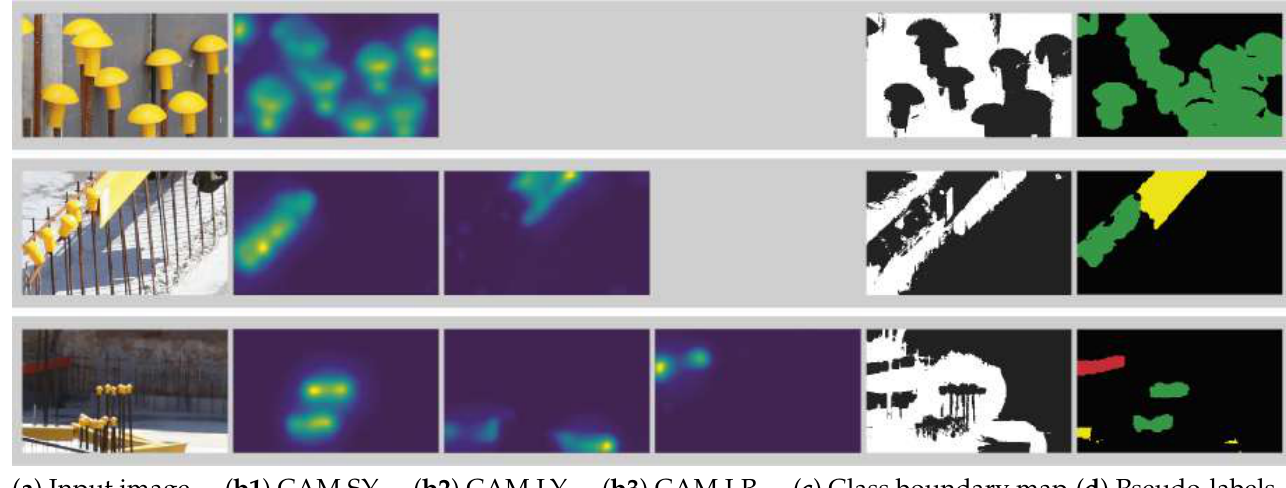
Figure 5. IRNet combines CAMs ( b1 – b3 ) and class boundary maps ( c ) to create the pseudo-labels ( d ) for the input images ( a ). Note that the top input image contains objects of only one and the middle image objects of only two classes, hence the different number of CAM images.